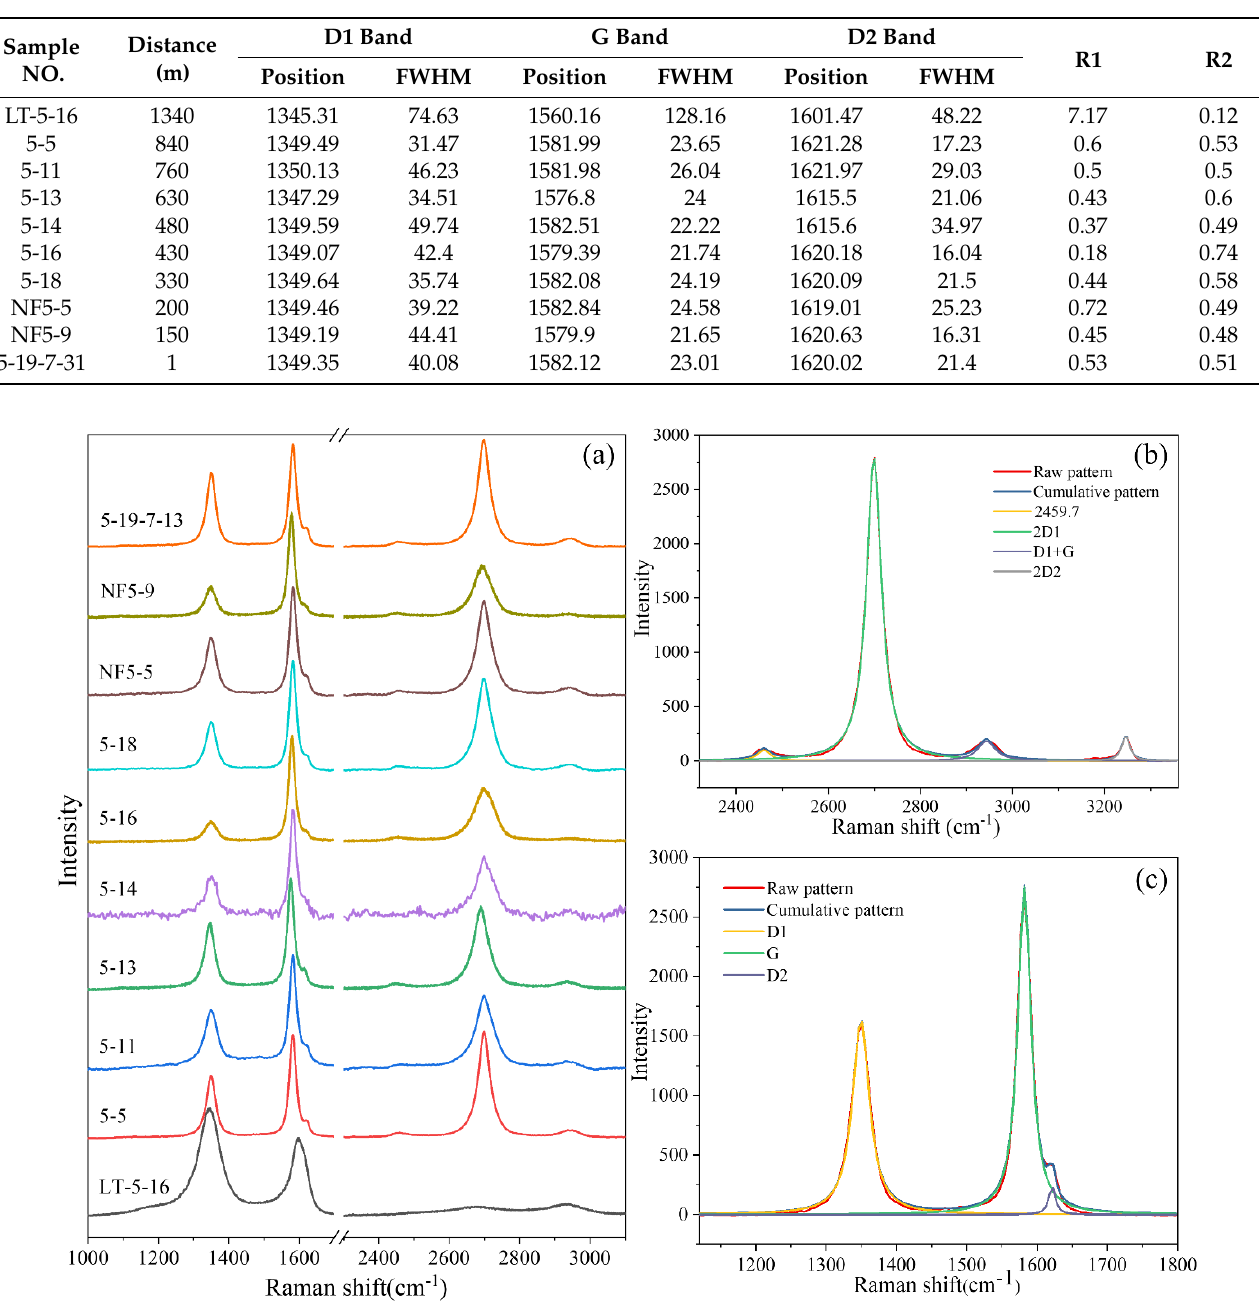
Table 3. The Raman spectral parameters derived from peak fitting of the series samples.